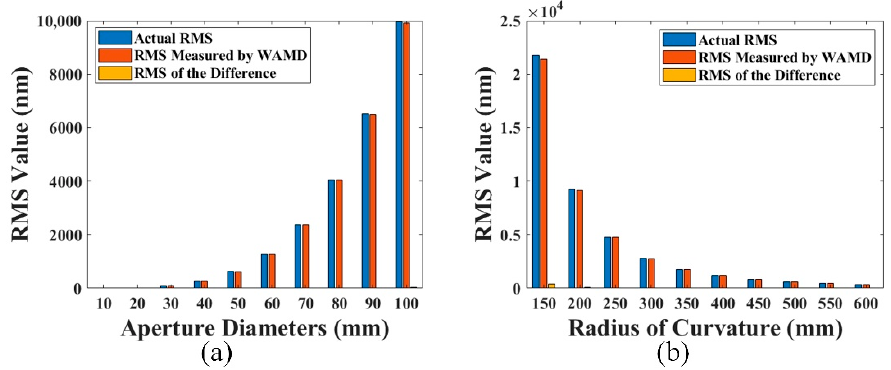
Figure 5. Comparisons between the actual wavefront aberrations and wavefront aberrations meas- ured by WAMD of: ( a ) lenses with different aperture diameters (radius of curvature: 500 mm ; thick- ness: 8 mm ; refractive index: 1.5168 ); ( b ) lenses with different radius of curvatures (aperture diam- eter: 50 mm ; thickness: 15 mm ; refractive index: 1.5168 ).